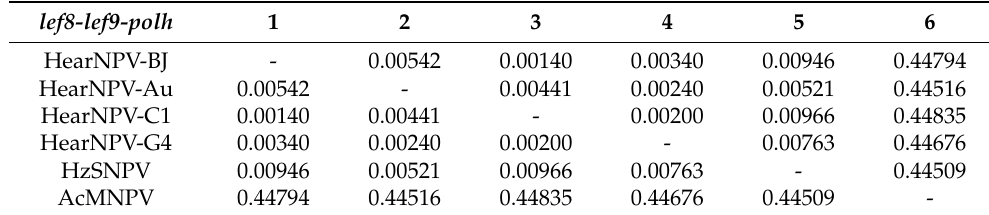
Table 2. Pairwise distances between the nucleotide sequences of lef8-lef9-polh tandem arranged sequences were calculated by Kimura 2-parameter model.